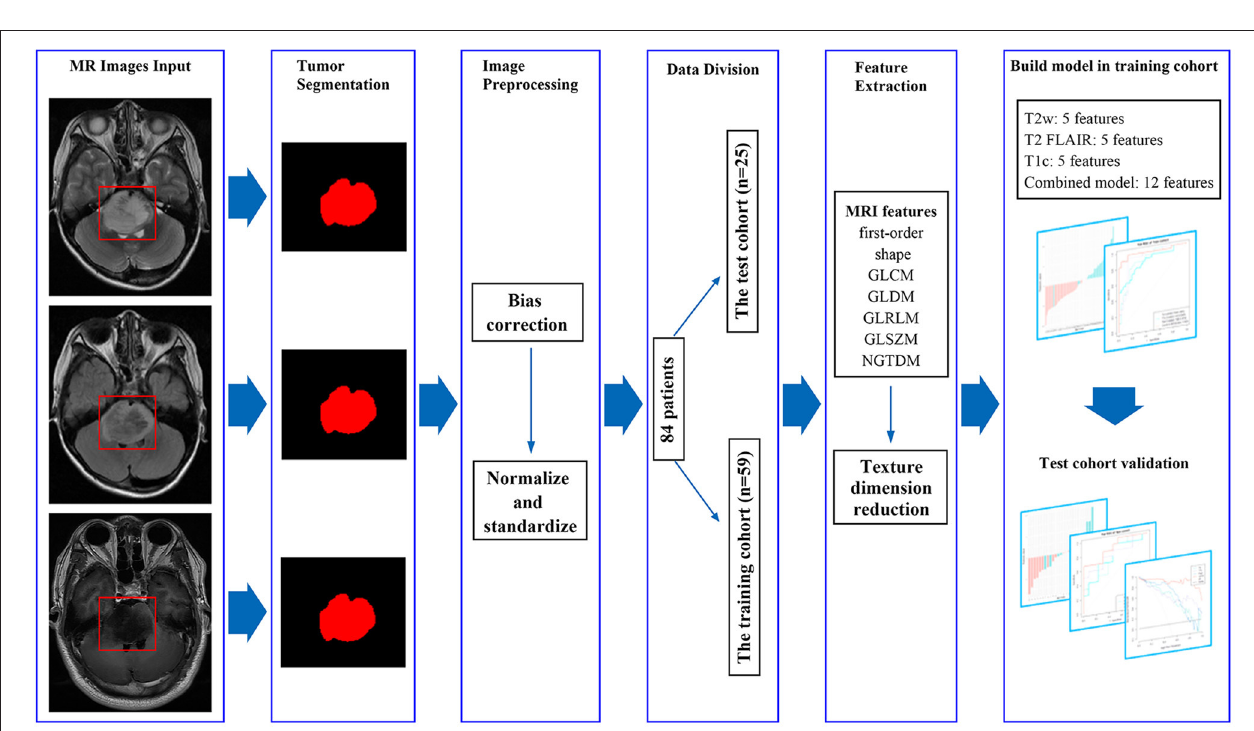
FIGURE 2 | MRI feature extraction and machine learning flow chart. By manually segmenting the tumors, we extracted 1,316 imaging features from masked preoperative T2w, T2 FLAIR, and T1c images. The variance method and maximum relevance and minimum redundancy were used to select the best features, and the four models were established. The test cohort was then used to verify the